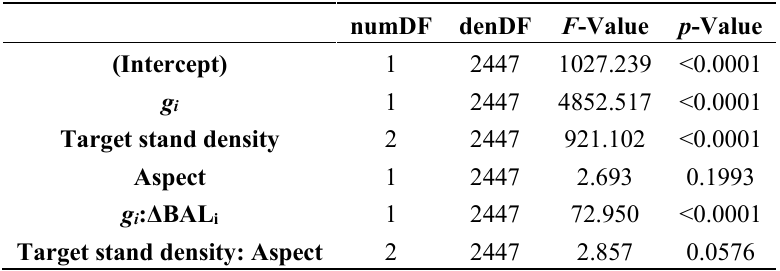
Figure 3. Annual tree basal area increment ( ig i ) according to target stand density (CT: 24.5 m 2 /ha, ST: 15 m 2 /ha, and VT: 10 m 2 /ha), and aspect (NE, SW). Basal area increments marked with the same letter are not significantly different ( p > 0.05). Table 5. Analysis of variance of the individual tree-level model.